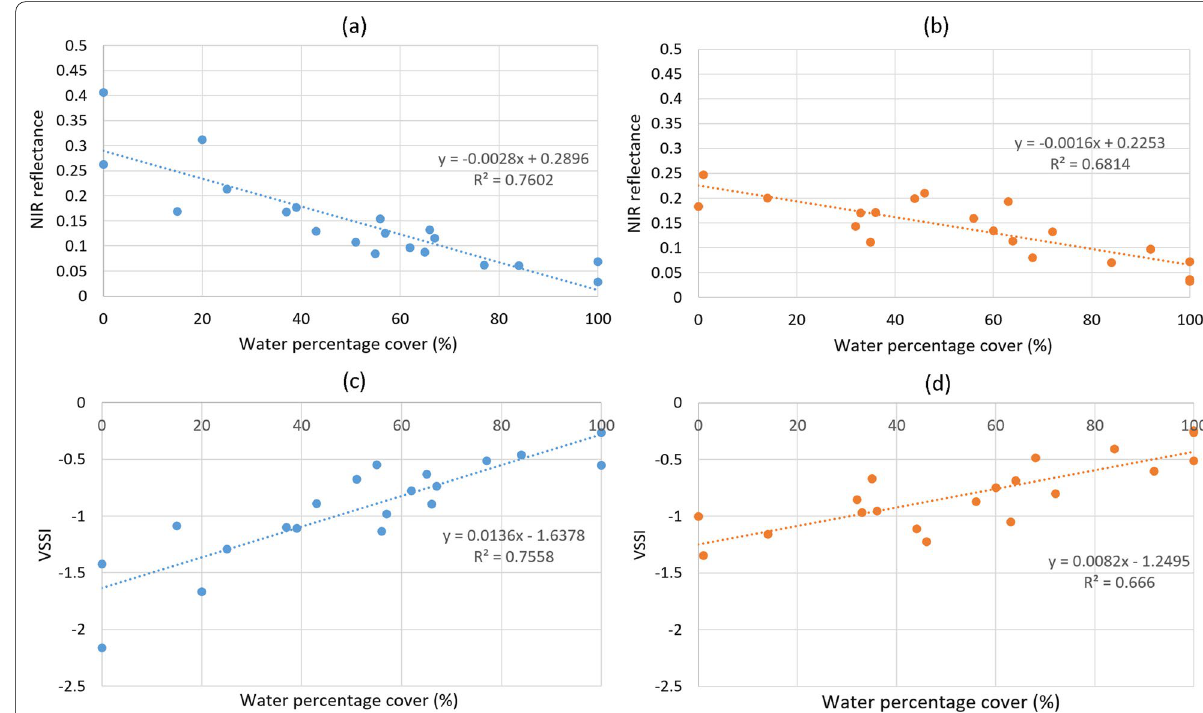
Fig. 3 Relationship of the L8 NIR reflectance with the water percentage cover in a the coastal area and b in the freshwater area (plot A and plot B of Fig. 1, respectively). Relationship of the VSSI with the water percentage cover ( c ) in the coastal area and d in the freshwater